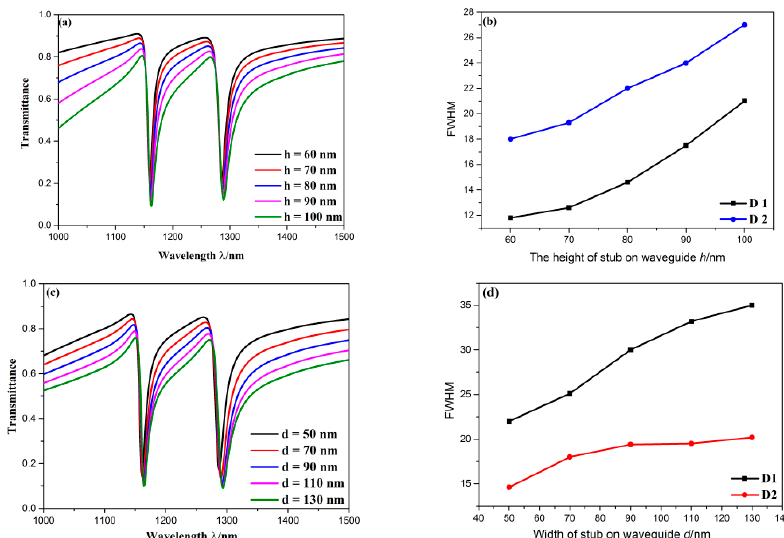
Figure 8. ( a ) Transmission spectra for diverse height of stub on bus waveguide; ( b ) the varying FWHM with rising of height of stub on bus waveguide; ( c ) transmission spectra for diverse width of stub on bus waveguide; ( d ) the varying FWHM with rising of width of stub on bus waveguide.